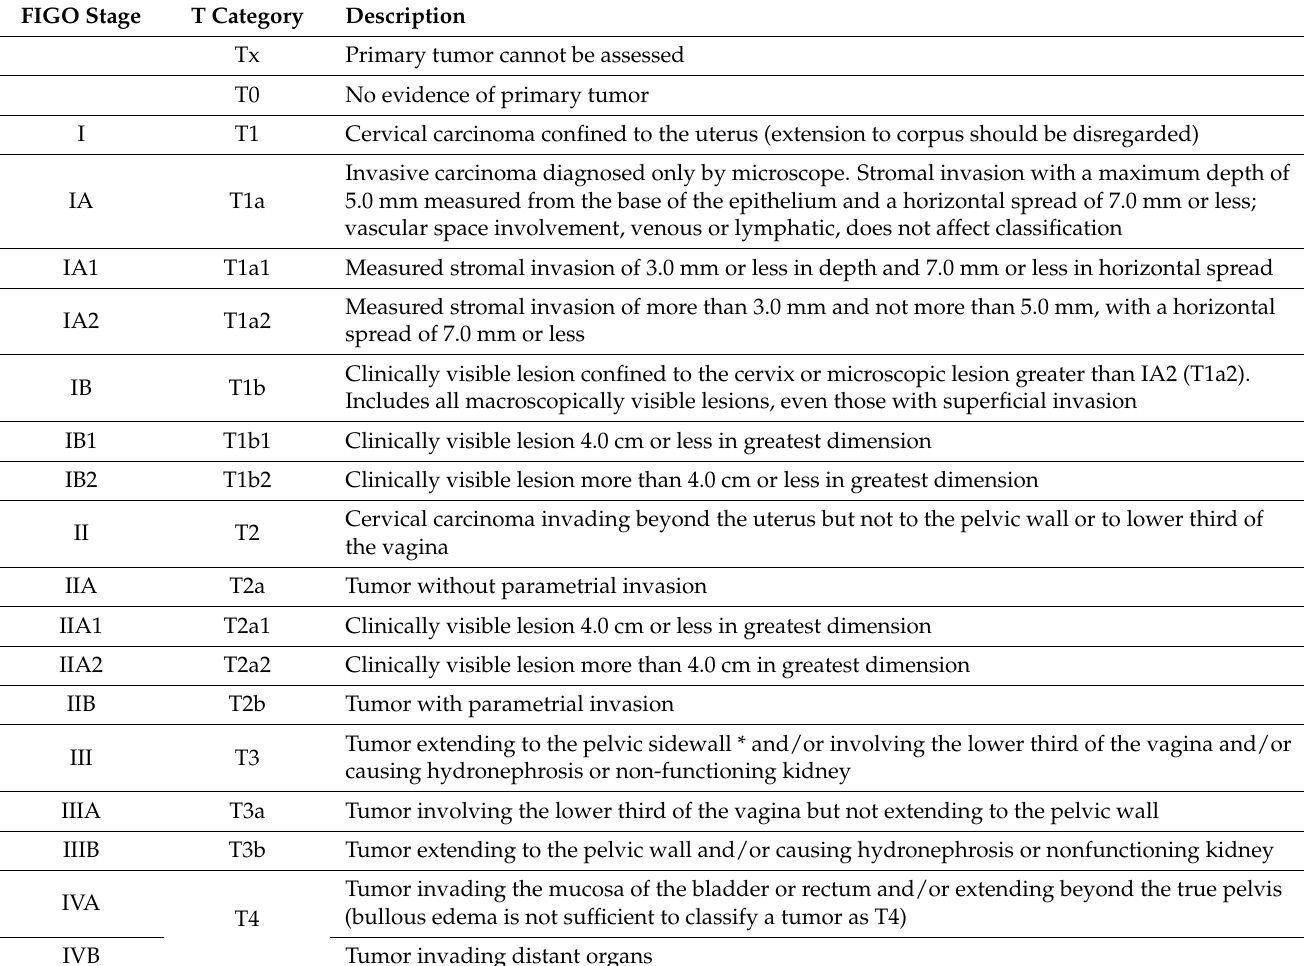
Table 4. FIGO staging for cervical cancers (Cibula et al., 2018 [36]). FIGO, International Federation of Gynecology and Obstetrics grading; T, tumor; x, any number. * Pelvic sidewall is defined as the muscle, fascia, neurovascular structures, and skeletal portions of the bony